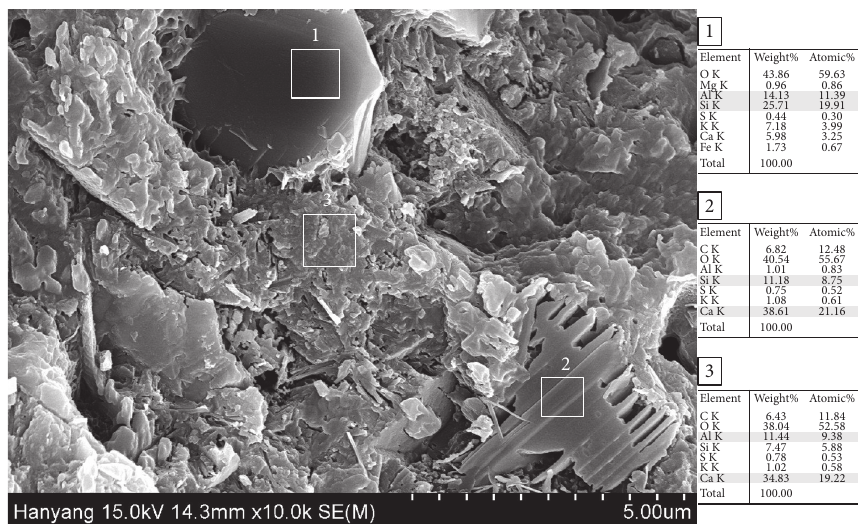
Figure 13: SEM view and chemical detected property by EDX of LGP12 10% (28 days).